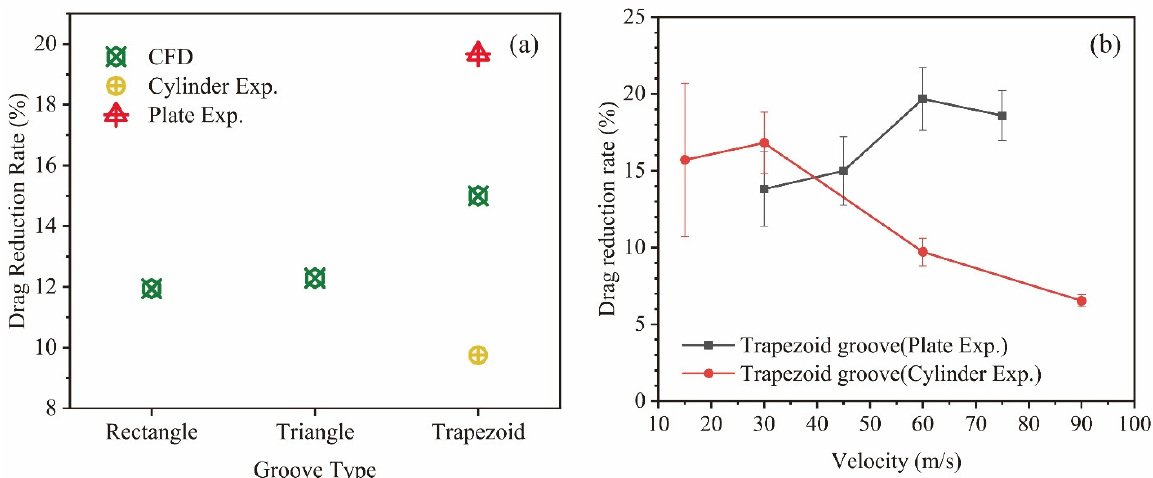
Figure 11. The drag reduction rate of CFD analysis and wind tunnel experiments: ( a ) the drag reduction rate of CFD analysis and experiment at the velocity of 60 m/s; ( b ) the drag reduction rate of experiments for cylinder and plate models.